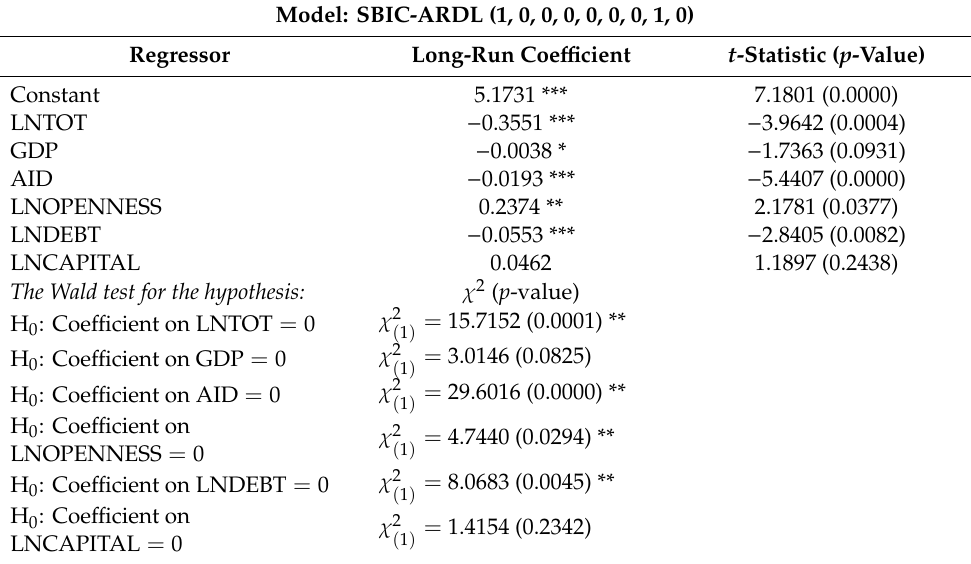
Table 2. Long-run coe ffi cients of the determinants of LNREER (restricted